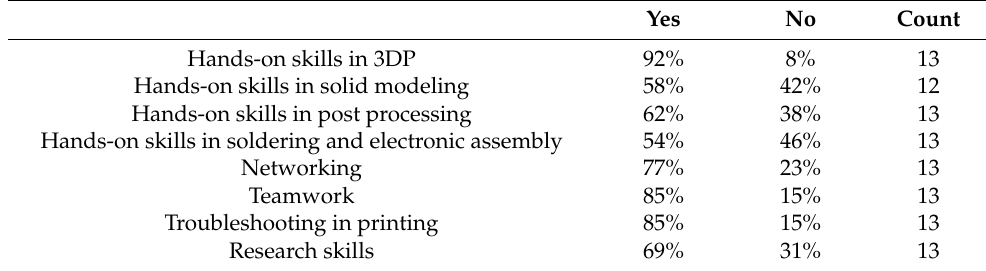
Table 1. Percentage of iMakerSpace users who experienced each of the listed items.